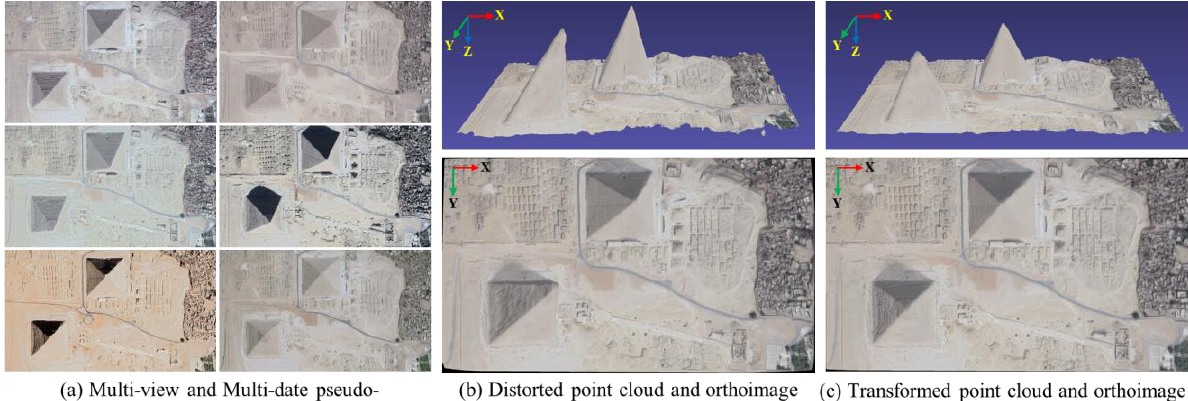
Figure 1 . The 3D surface reconstruction result of Eygpt-pyramid GE satellite images. (a) is multi-view and multi-date pseudo- orthoimages of Google Earth, (b) is the result of point cloud and orthoimage using MVS and incorrect camera pose geometry. The high-rise structure is reconstructed distorted (slantly). And (c) is the result of proposed method. The distorted point cloud is transformed as the orthographic projection model space using 3D homography-based projective reconstruction. Therefore, the correct orthoimage can also be